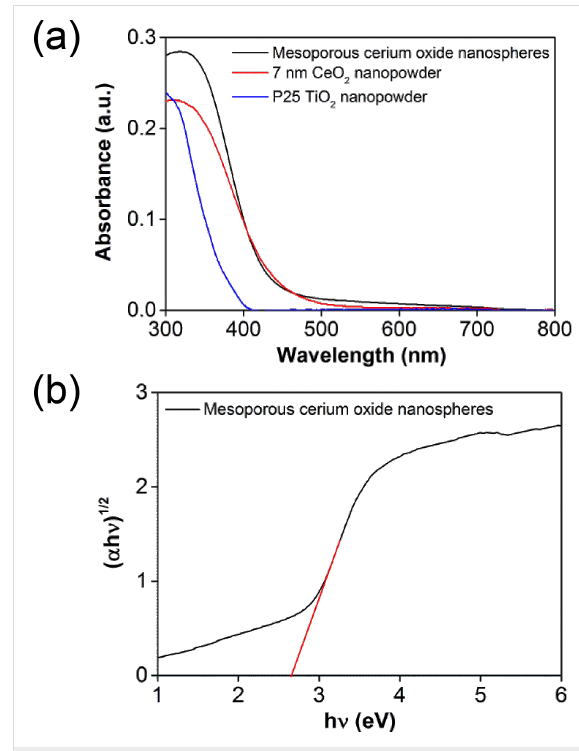
Figure 2: (a) UV–vis diffuse reflectance spectra of cerium oxide nano- spheres (black), 7 nm CeO 2 (red) nanopowder, and P25 TiO 2 (blue). (b) Tauc plot for cerium oxide to obtain the band